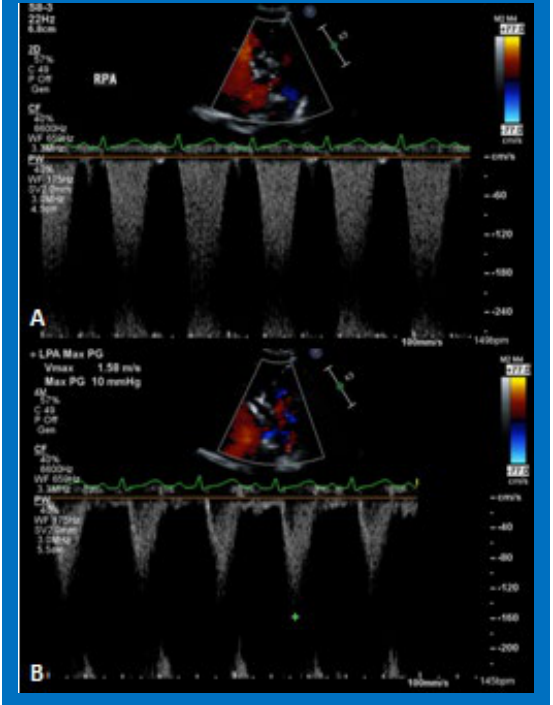
Figure 21. Selected video frames demonstrating flow acceleration across the right (RPA) ( A ) and left (LPA) ( B ) pulmonary arteries in a patient with a Blalock–Taussig shunt. These slightly higher than normal velocities do not indicate stenosis of the branch pulmonary arteries.